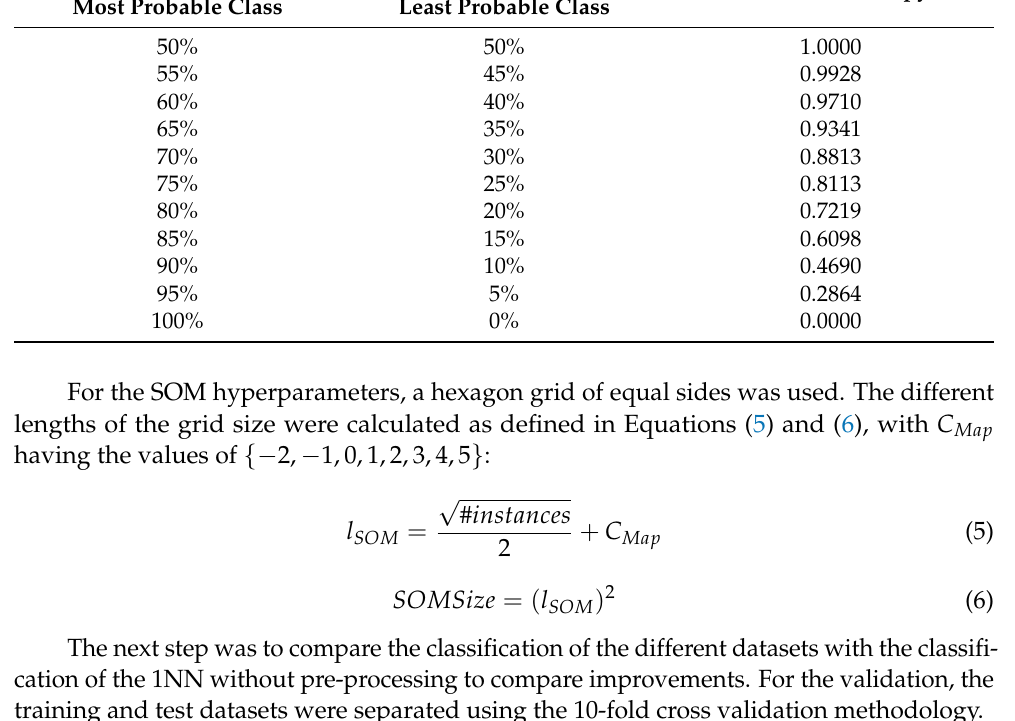
Table 3. The different entropy values used in the experiment. Ratio between the Classes Inside the